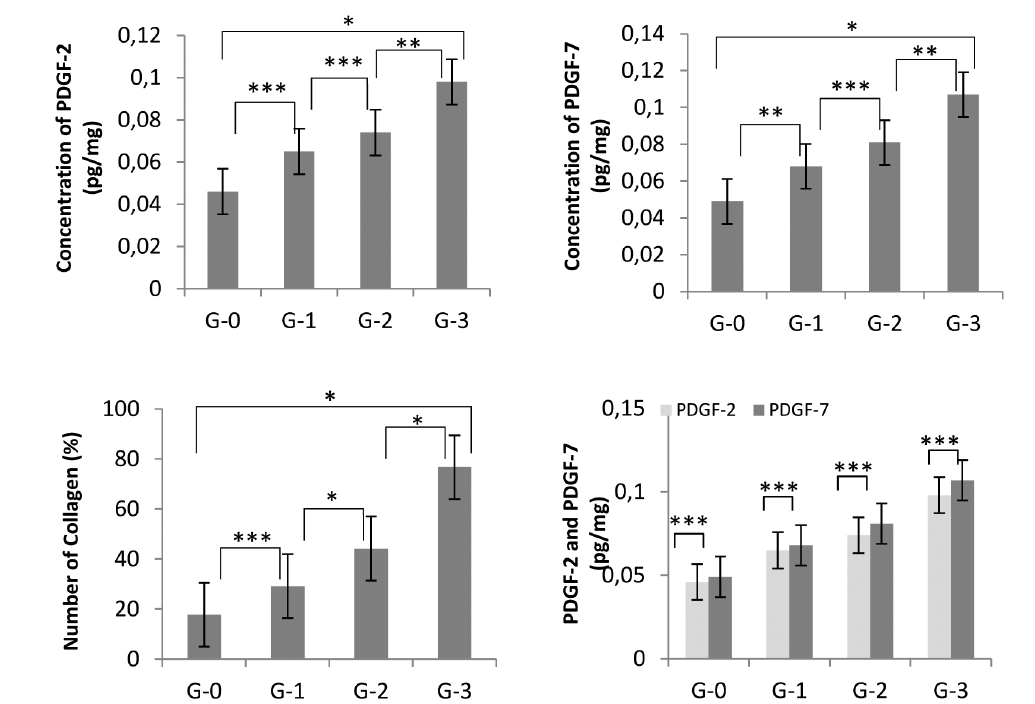
Figure 2. Concentration of PDGF-2, PDGF-7, and Number of Collagen, and Correlation between PDGF-7 and Number of Collagen. Note: * p < 0.001; ** p < 0.05; *** p >